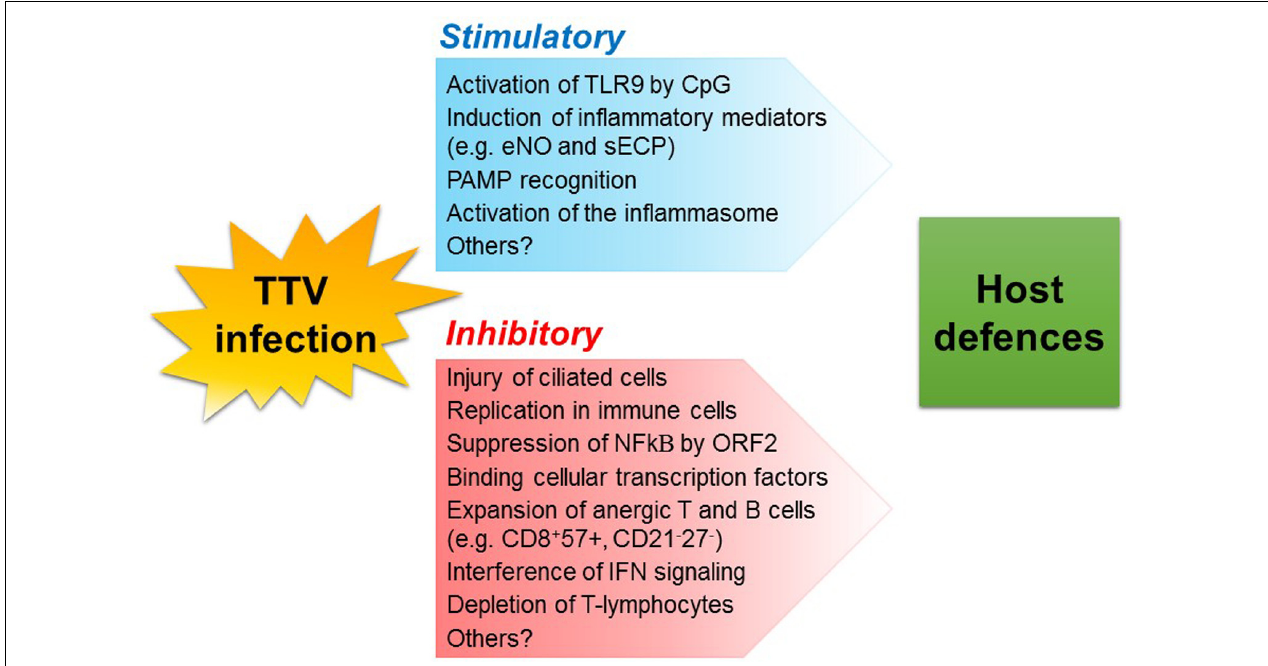
FIGURE 1 | Possible mechanisms whereby TTV infection may modulate host defenses. TLR, toll-like receptor; CpG, unmethylated heterodimers of guanosine and cytosine; eNO, exhaled nitric oxide; sECP, secreted eosinophil cationic protein; PAMP, pathogen-associated molecular pattern.